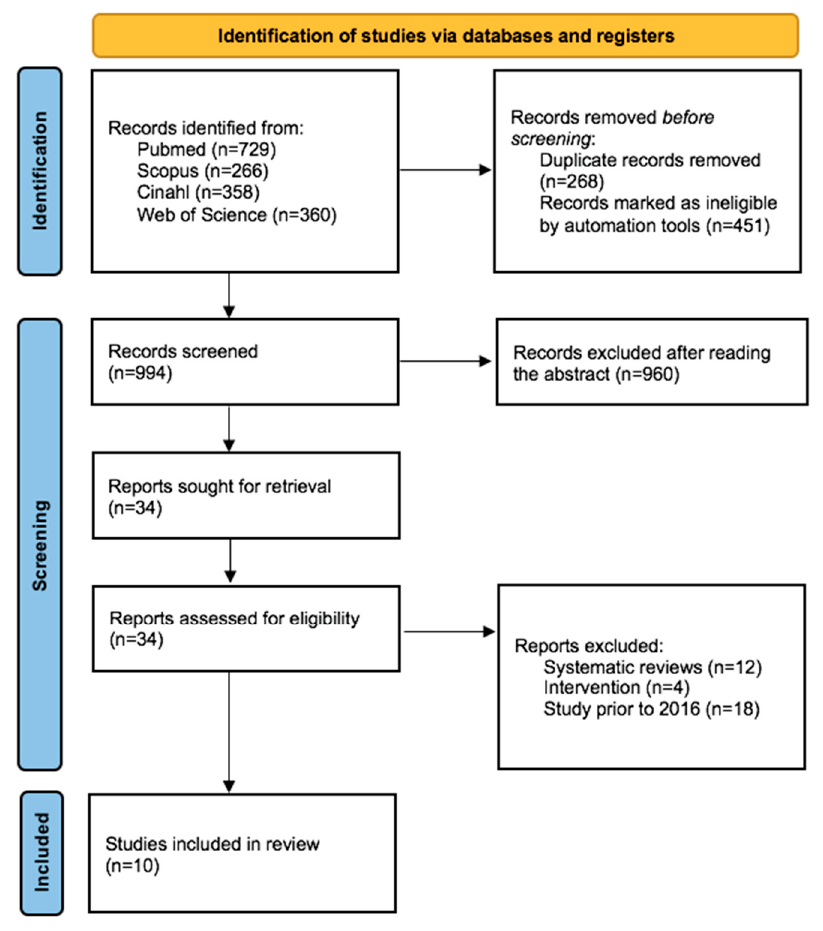
Figure 1. Flow Figure 1. Flow diagram.